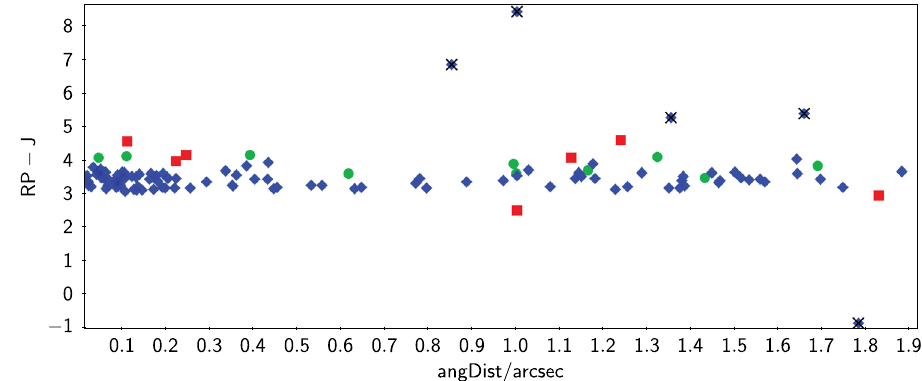
Figure 7: ( RP J − ) Color index to the distance between the object and the match. Crosses indicate suspicious matches.